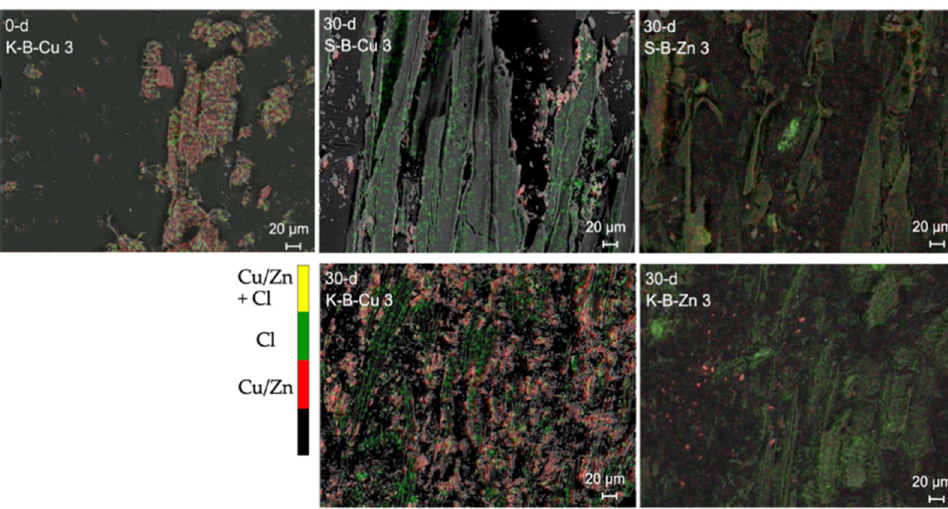
Figure 9. The BSE images combined with the electron probe micro-analyser (EPMA) maps of the 0- day-exposed K-B-Cu 3 and 30-day exposed S-B-Cu/Zn 3 and K-B-Cu/Zn 3.